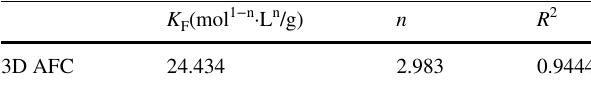
Table 1 The parameters of adsorption isotherm of Pb 2+ on the 3D AFC